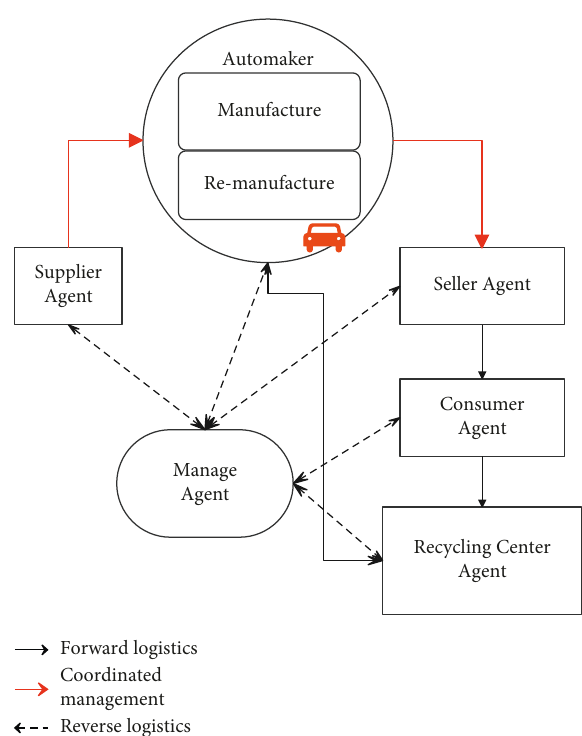
Figure 8: Model of the inventory control system for automobile reverse